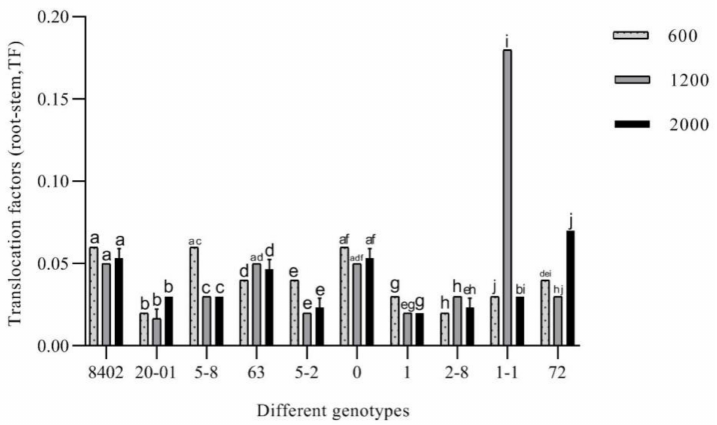
Figure 9. Root–stem transfer factors of C. bungei .